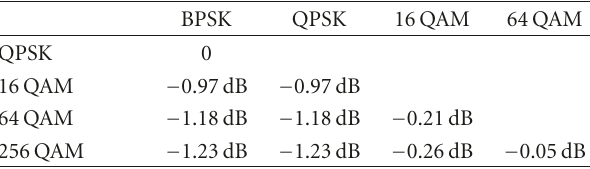
Table 4: Potential SNR loss in constellation conversion. Table 5: SNR threshold for rate adaptation (for a message consisting of 4800